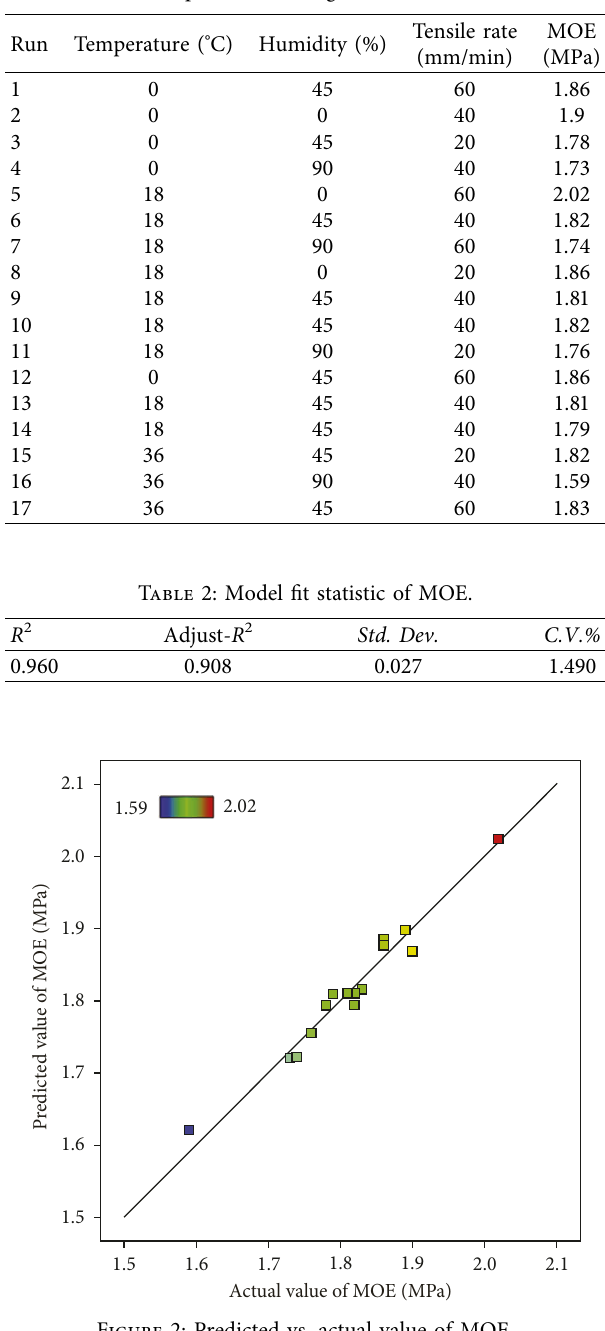
Table 1: Experimental design and result of MOE.